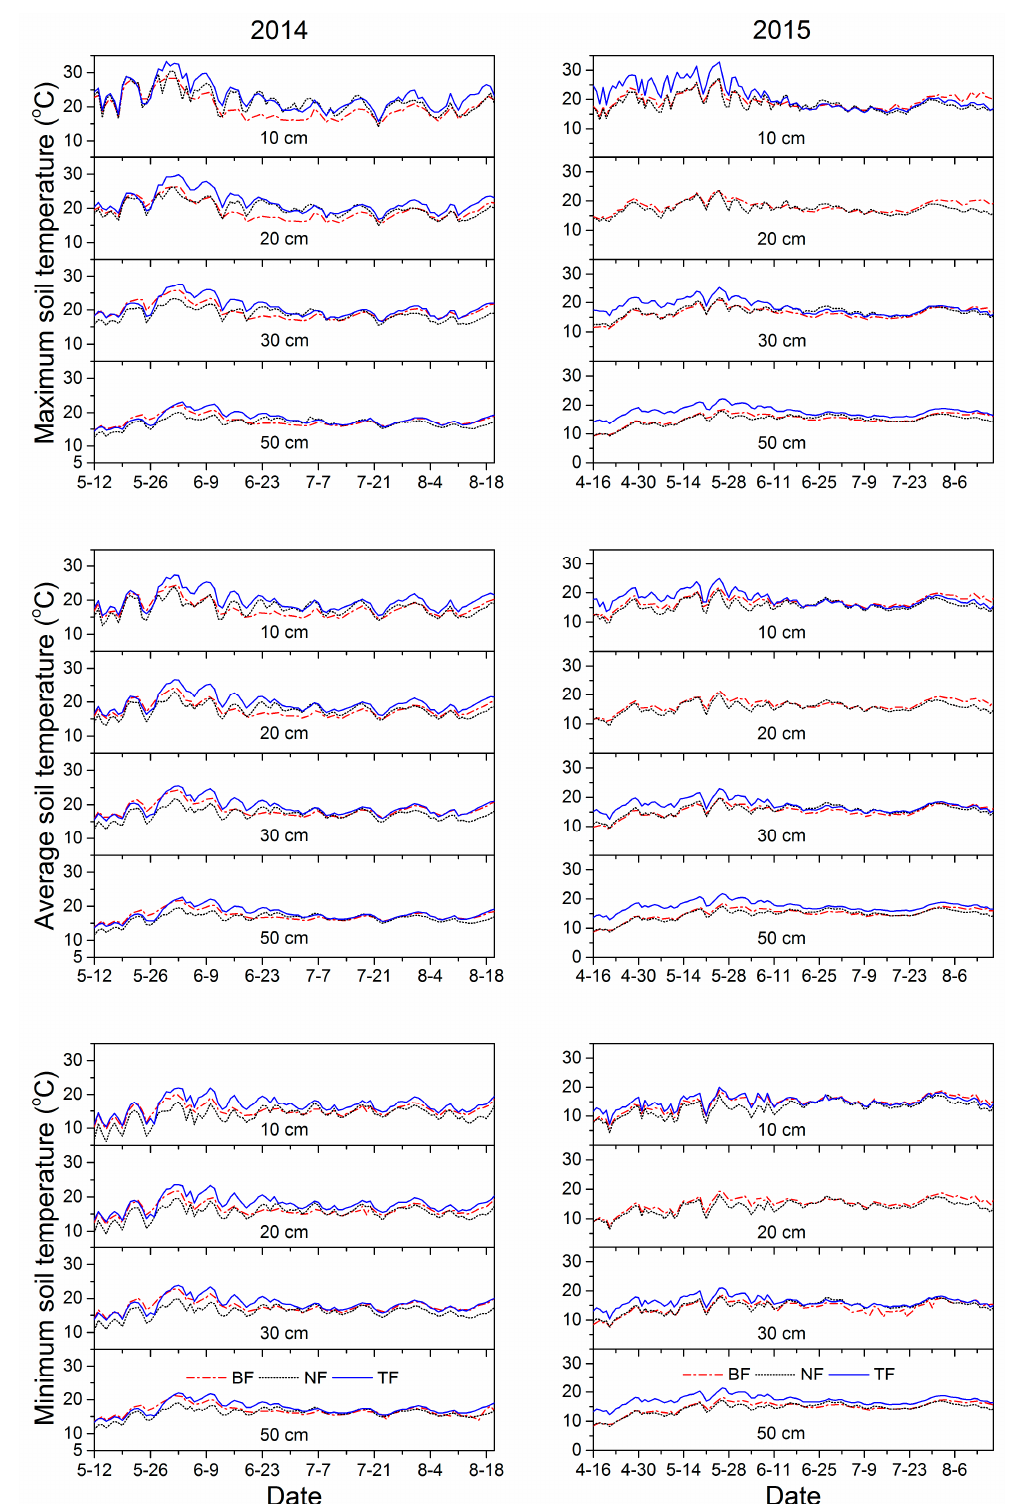
Figure 4. Seasonal variations of the daily maximum soil temperature, daily average soil temperature, and daily minimum soil temperature at 10–50 cm soil depths for different mulch treatments: black film (BF), no film (NF), and transparent film (TF) in 2014 and 2015.The soil temperature at 20 cm soil depth in 2015 was not shown because of data anomalies.